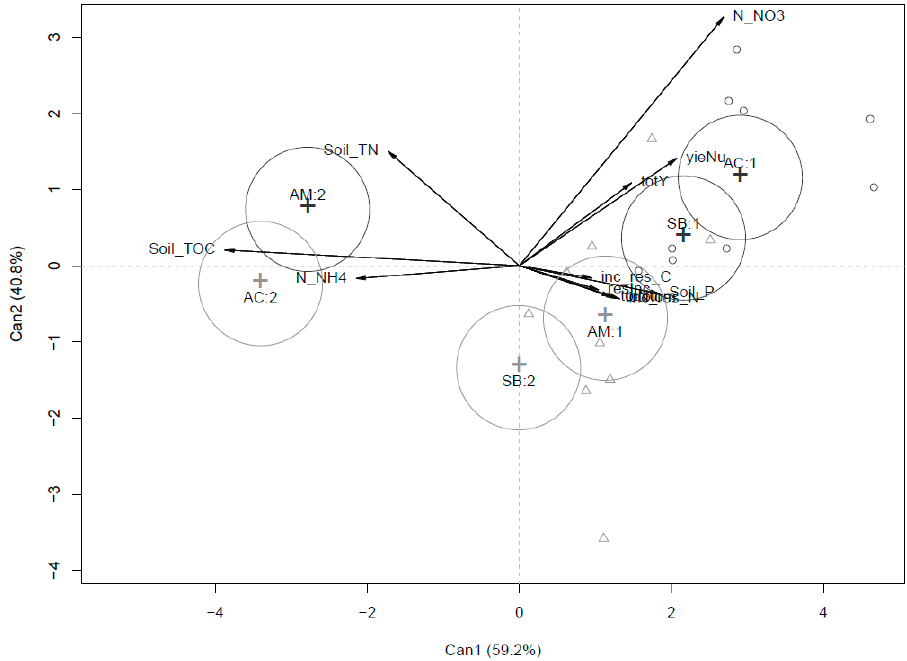
Figure 2. CDA output for agronomic parameters in the three compared systems (SB, AC and AM) over the two experimental years.